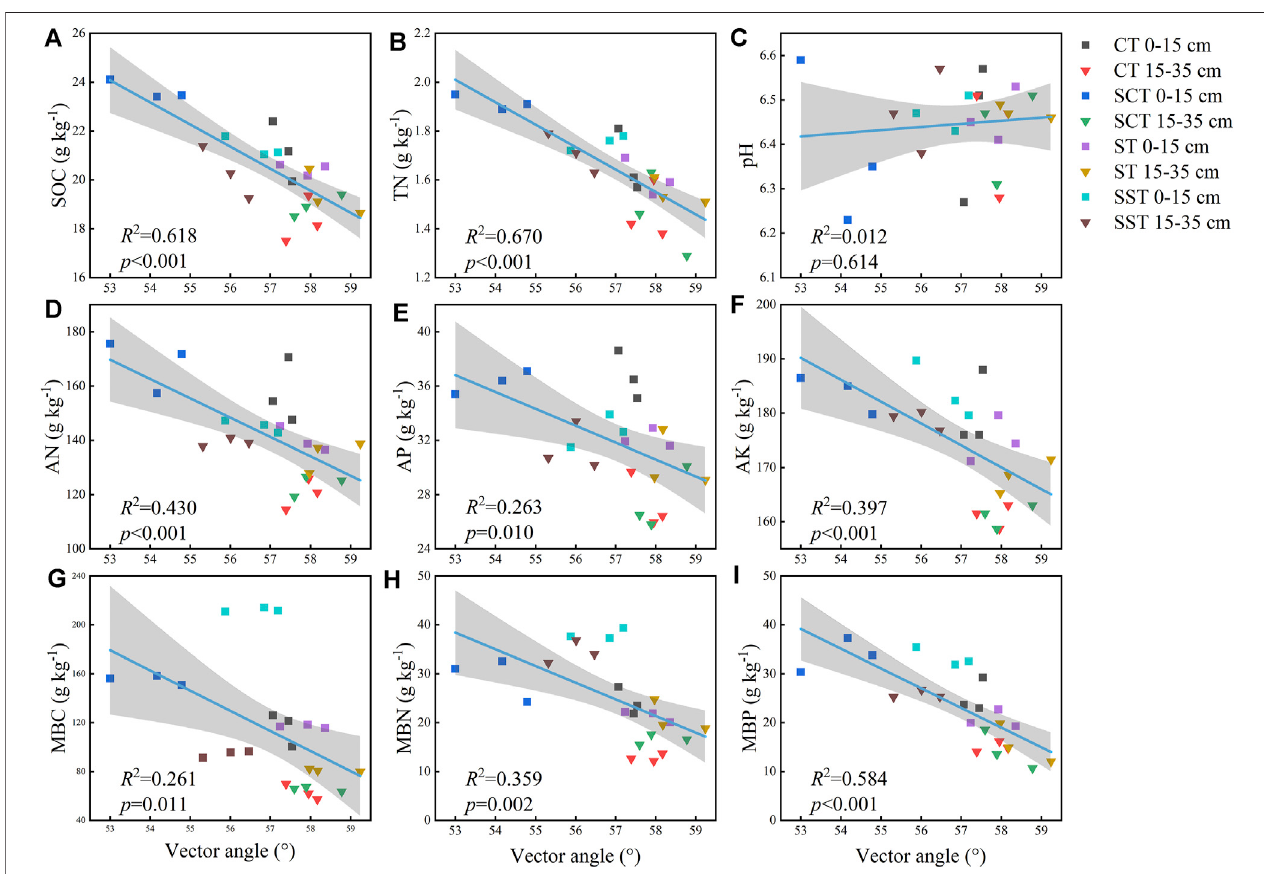
FIGURE 5 | Vector angles for the soil properties (A – I) . Solid lines indicate that the model fi t the vector angles and properties well, and the gray areas are the 95% con fi dence intervals of the models. See Materials and methods for abbreviation de fi nitions.